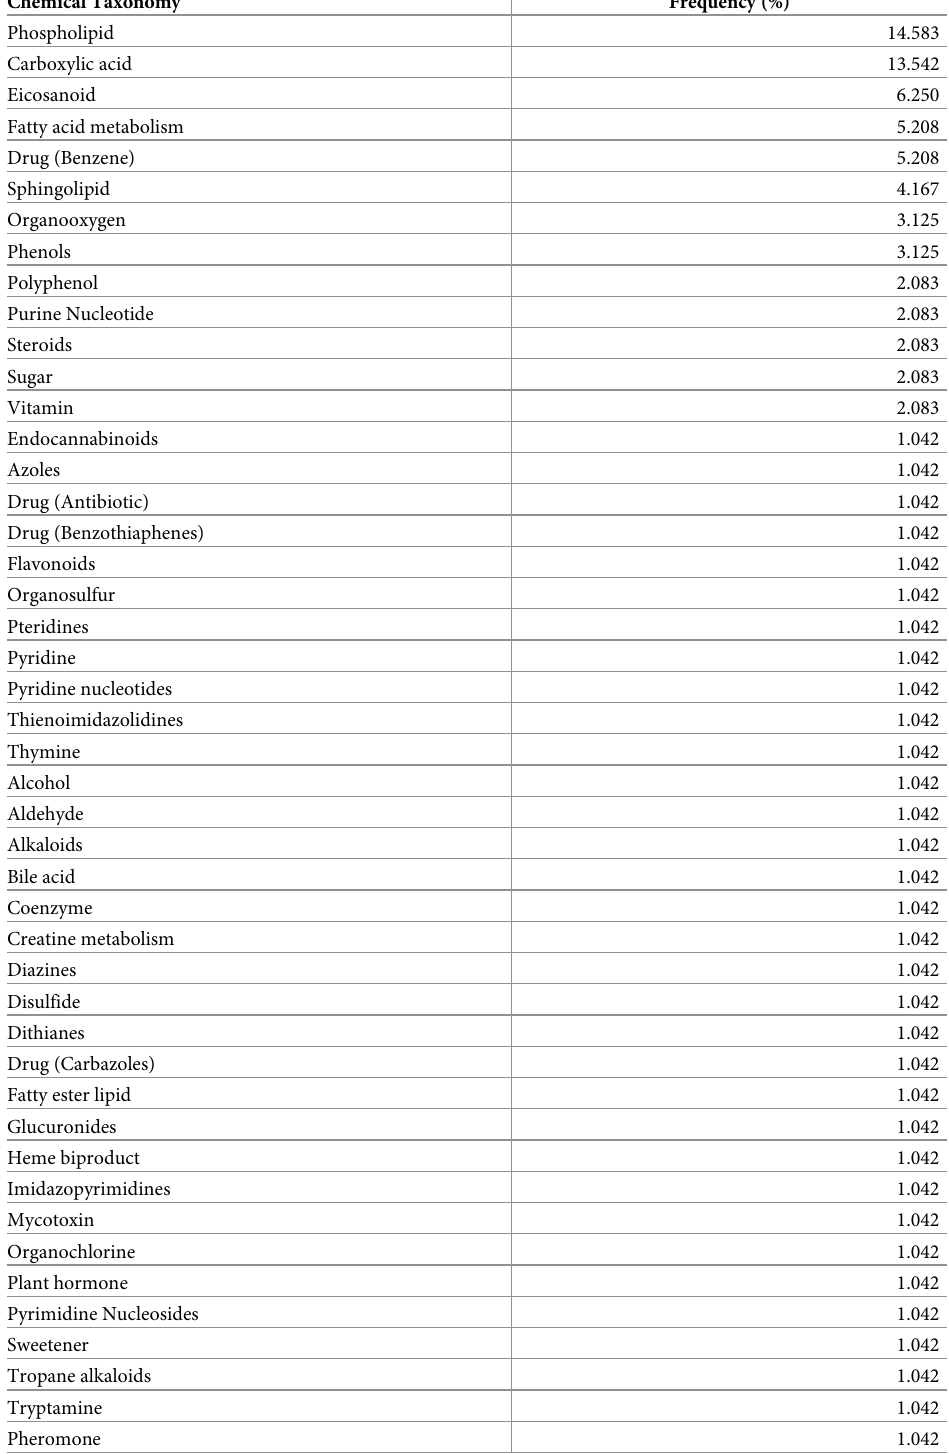
Table 3. Classification and frequency of 96 detected metabolites in blood samples collected from 42 patients based on their chemical